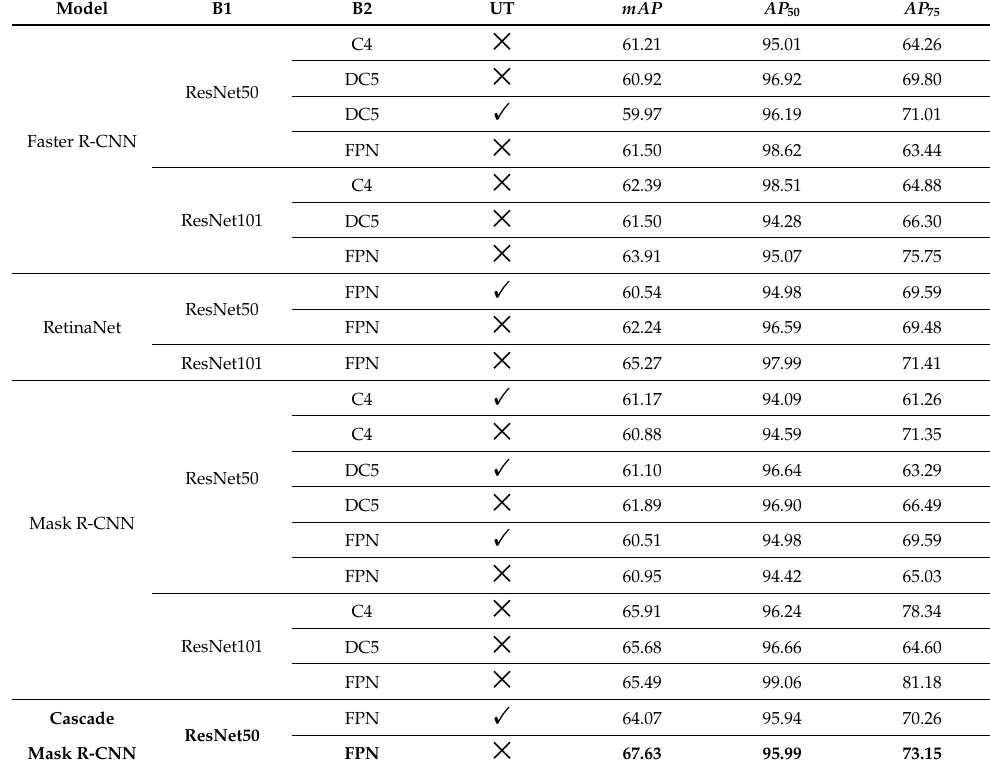
Table 3. Coco evaluation of the state-of-art object detection models of SSWD.